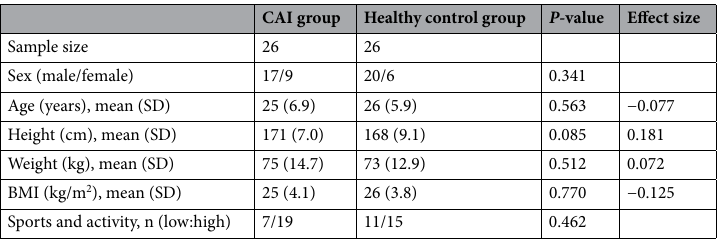
Table 1. Demographic data of the patients with CAI and healthy control subjects. CAI chronic ankle instability,; SD standard